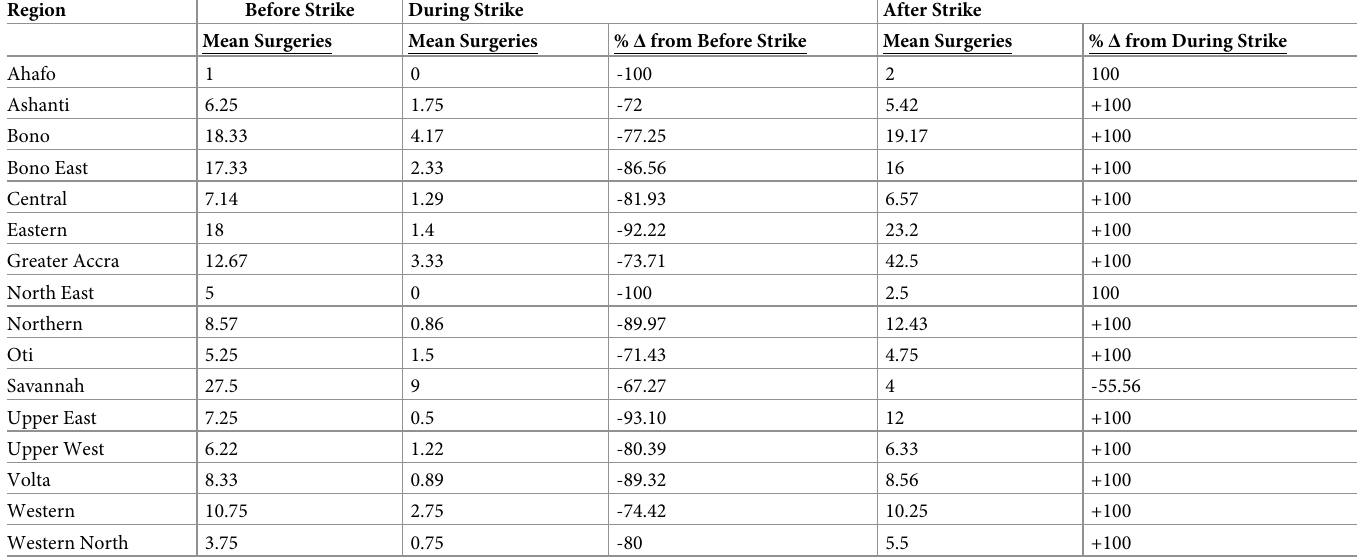
Table 5. Percentage change in the mean surgeries performed during and after strike. Region Before Strike During Strike After